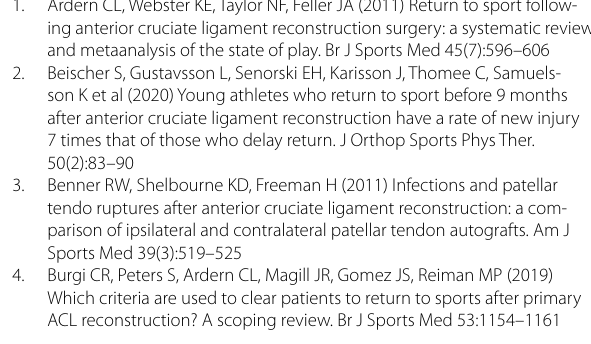
weakness compared to the preoperative condition. The resolving the early return-to-play issue securely.